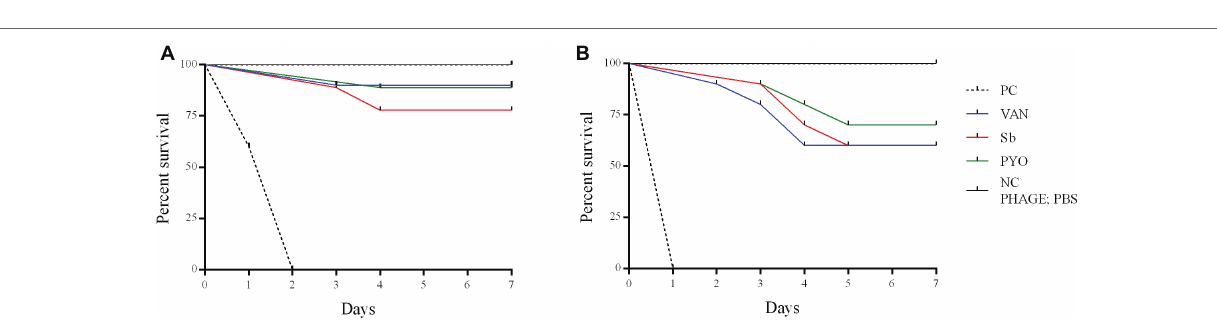
FIGURE 12 | Impact of single phage and vancomycin doses on prevention of MRSA infection and survival rates of G. mellonella larvae . A single phage dose (10 5 PFU/ml) was injected 1 h before the larvae was infected with (A) 2.5–5 × 10 6 CFU/ml (B) 2.5–5 × 10 7 CFU/ml of bacteria. PC, untreated control; NC, non- manipulated; PBS, phosphate-buffered saline.